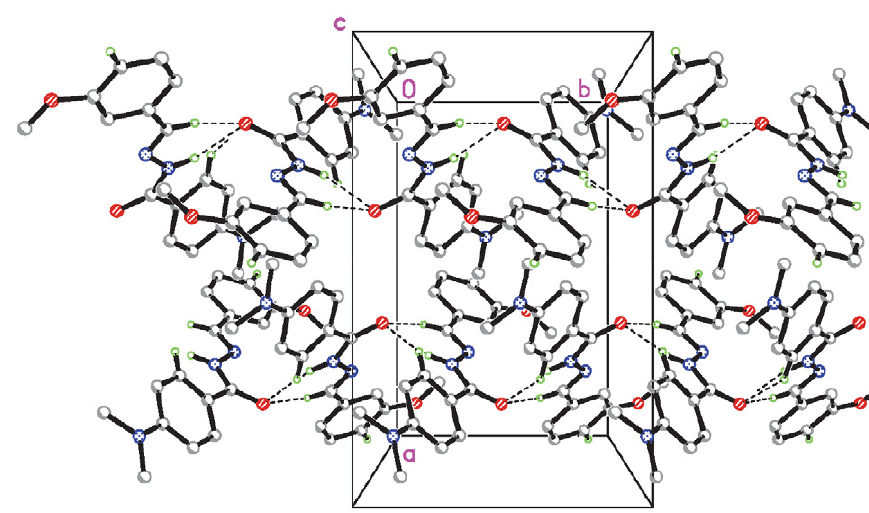
Figure 6. The packing diagram of 3 . Hydrogen bonding interactions are shown as dashed